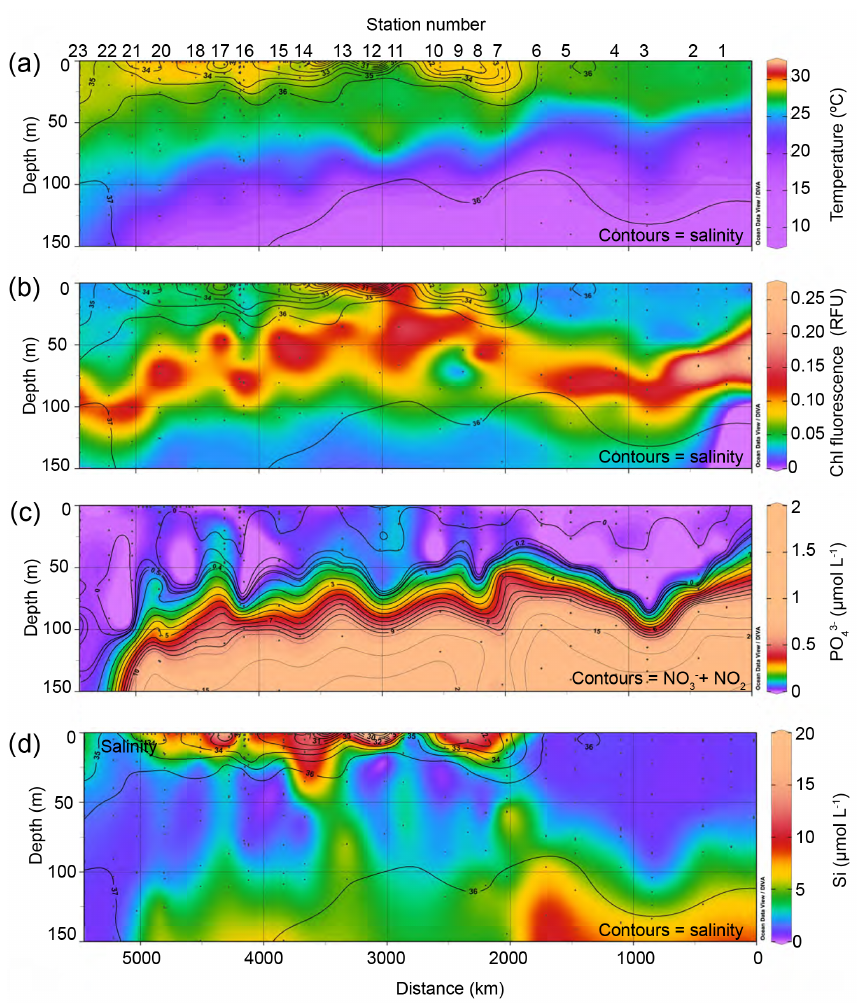
Figure 3. Water column characteristics along the cruise track. Color scales show (a) temperature, (b) chlorophyll fluorescence (from fluo- rometer on CTD), (c) PO 3 − (color scale) and (d) Si. Contour lines show salinity (a, b, d) and NO − 4 plots, distance along transect from the Cabo Verde islands